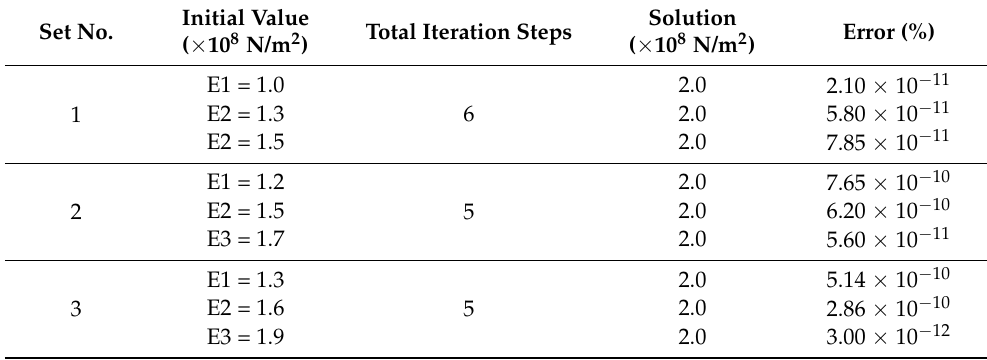
Table 4. Iteration results with different initial